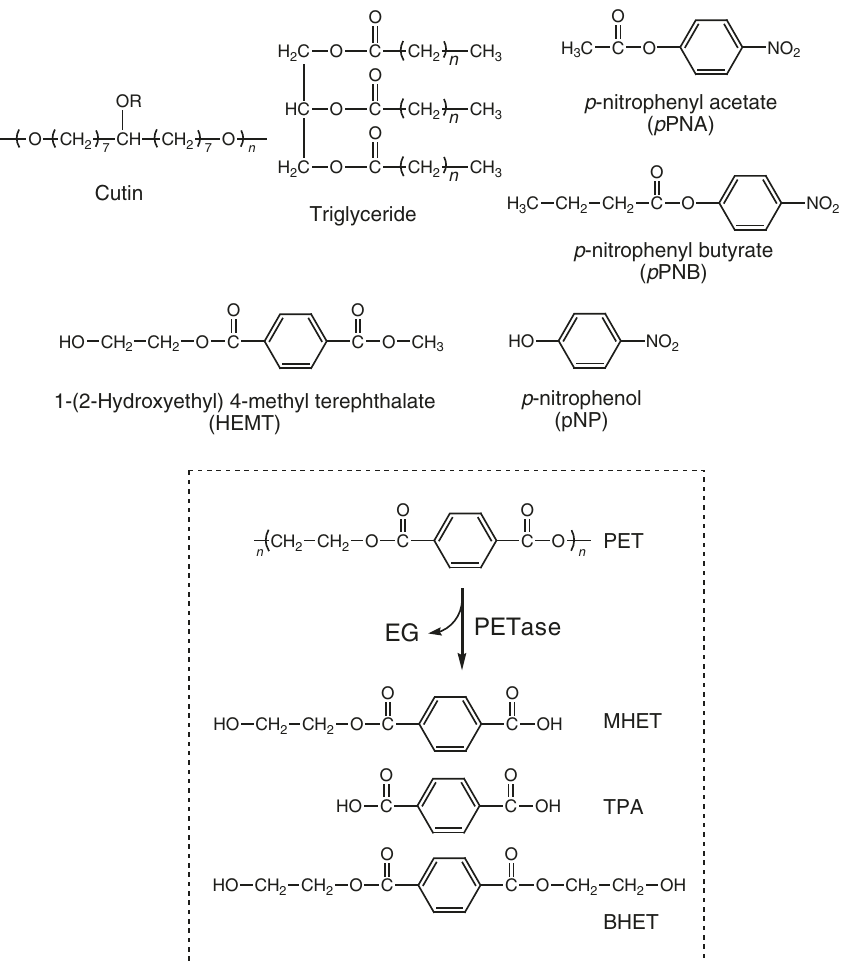
Fig. 1 Structures of PETase hydrolysis products (boxed) and other compounds used in this